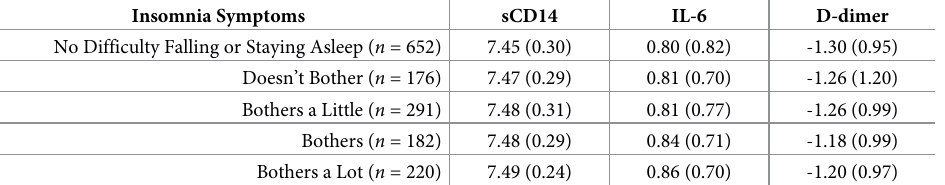
Table 2. Biomarker levels across insomnia symptom categories of veterans with HIV in the VACS biomarker cohort. Insomnia